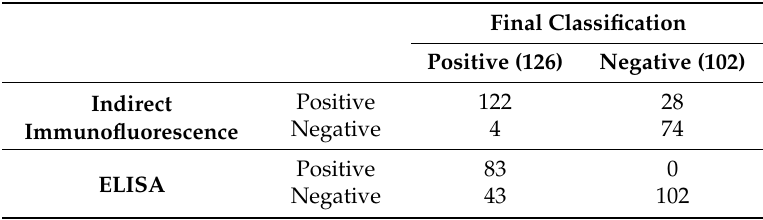
Table 5. Performance characteristics of IIF and ELISA after the final classification of